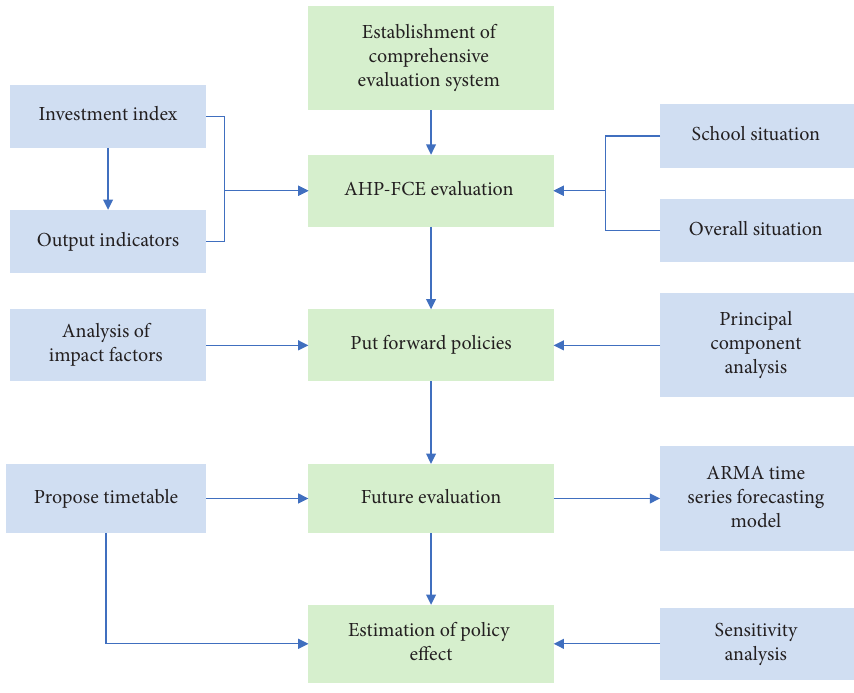
Figure 1: Overall thinking